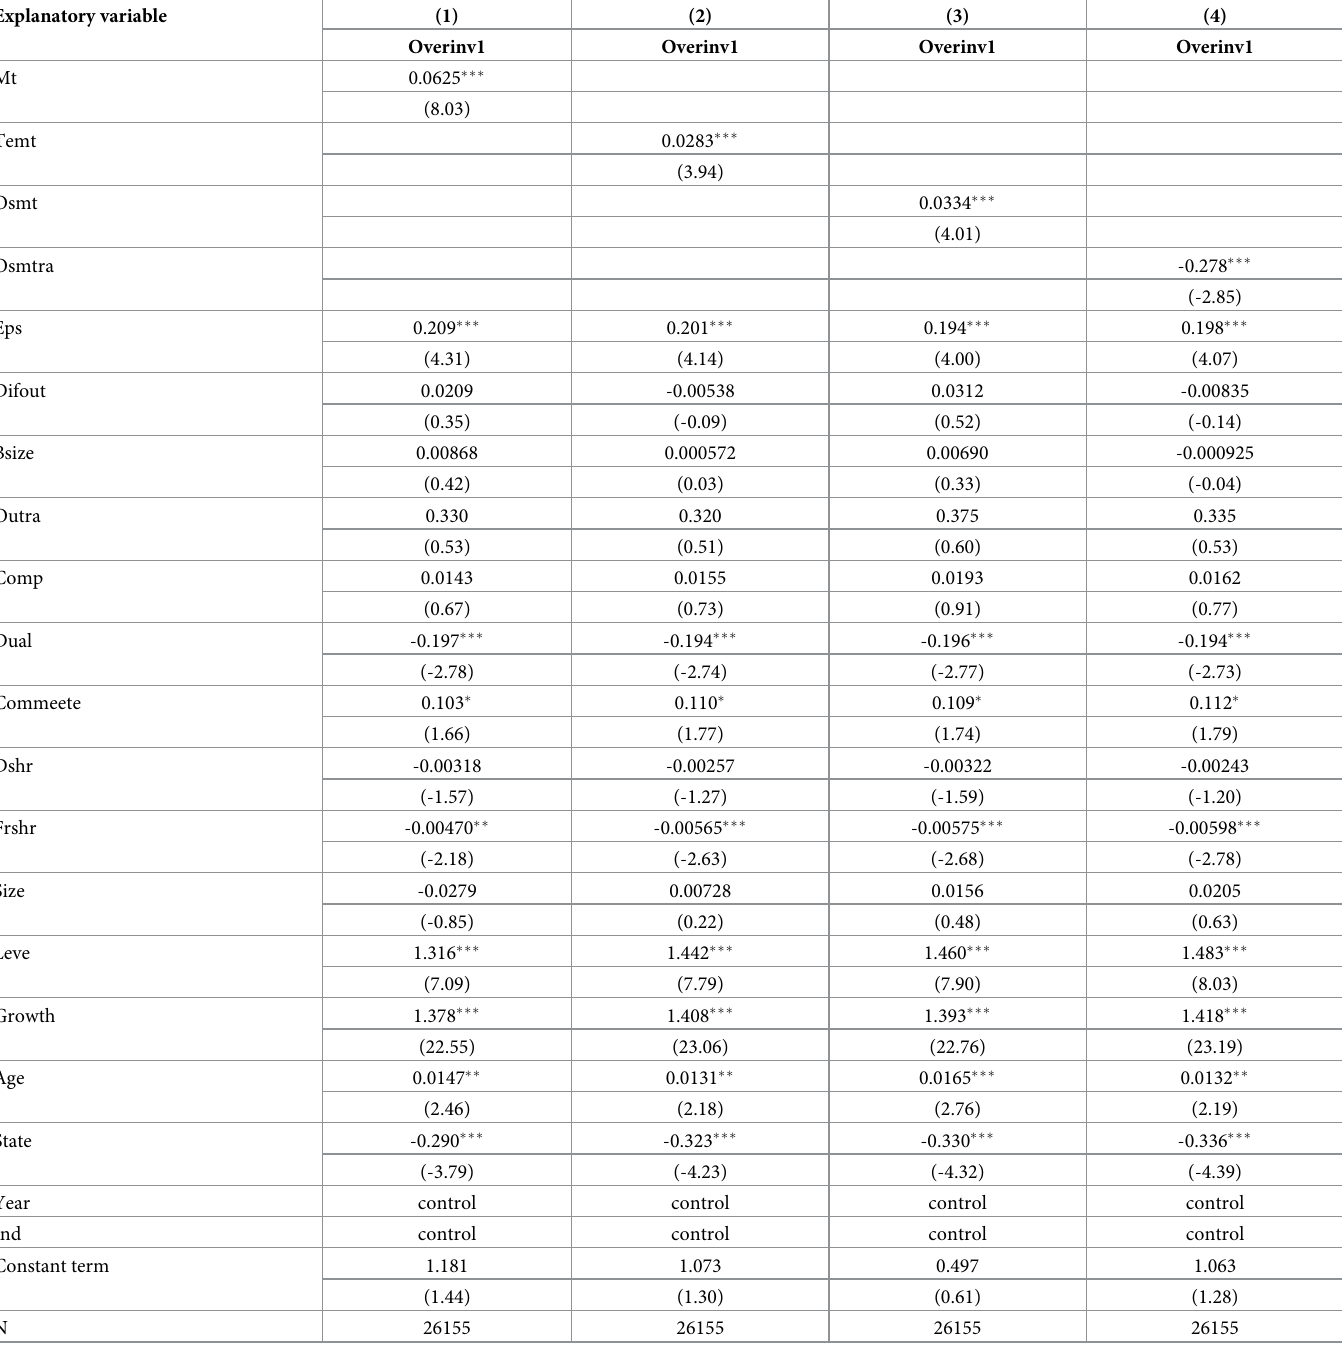
Table 3. The regression results of the number of board meetings, the number of communication meetings, the number and proportion of on-site meetings, and the